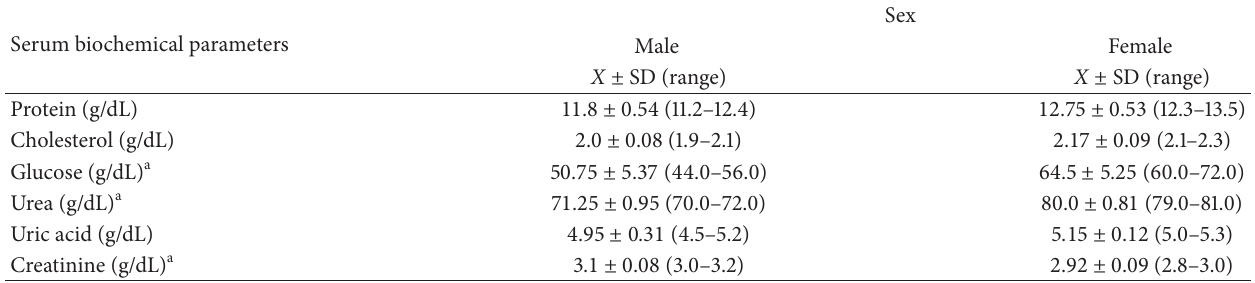
Table 2: Serum biochemical parameters observed in adult males and females of Polypedates